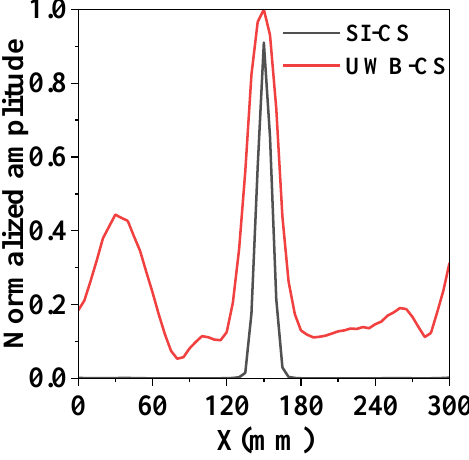
Figure 6. The trend of the peak in the lateral direction at the PIM source location for the UWB-CS method and the SI-CS method.